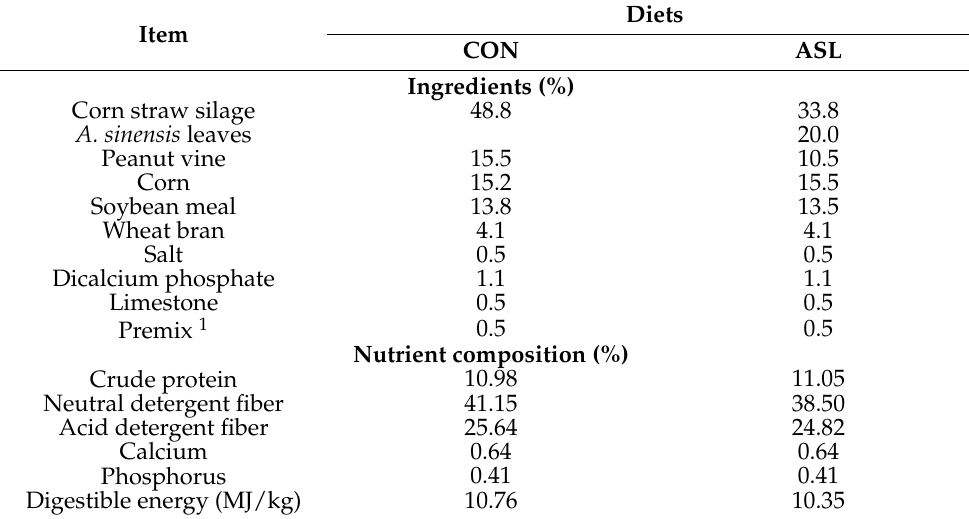
Table 1. Dietary ingredients and nutrient composition (dry matter basis) of fattening goats between two